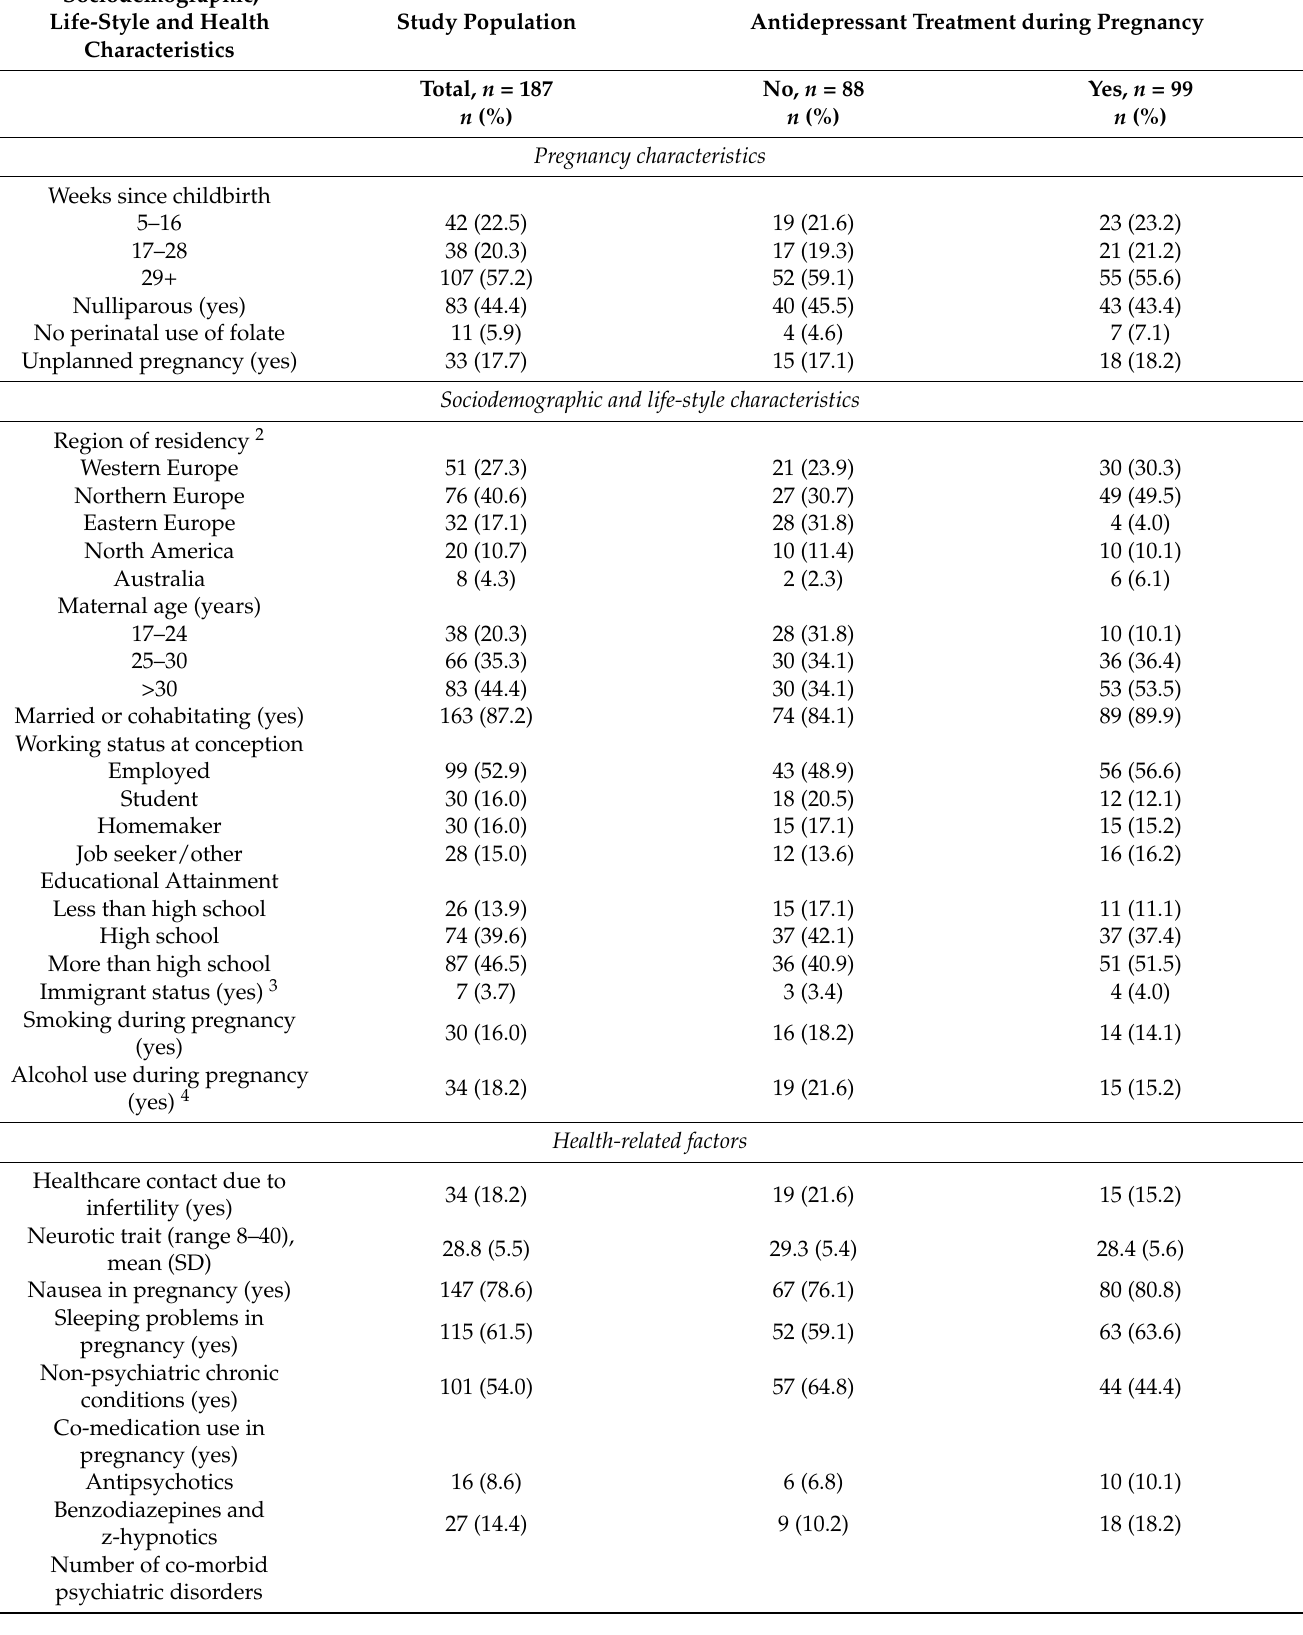
Table 1. Maternal sociodemographic, lifestyle and health-related characteristics of the study population by antidepressant treatment during pregnancy 1